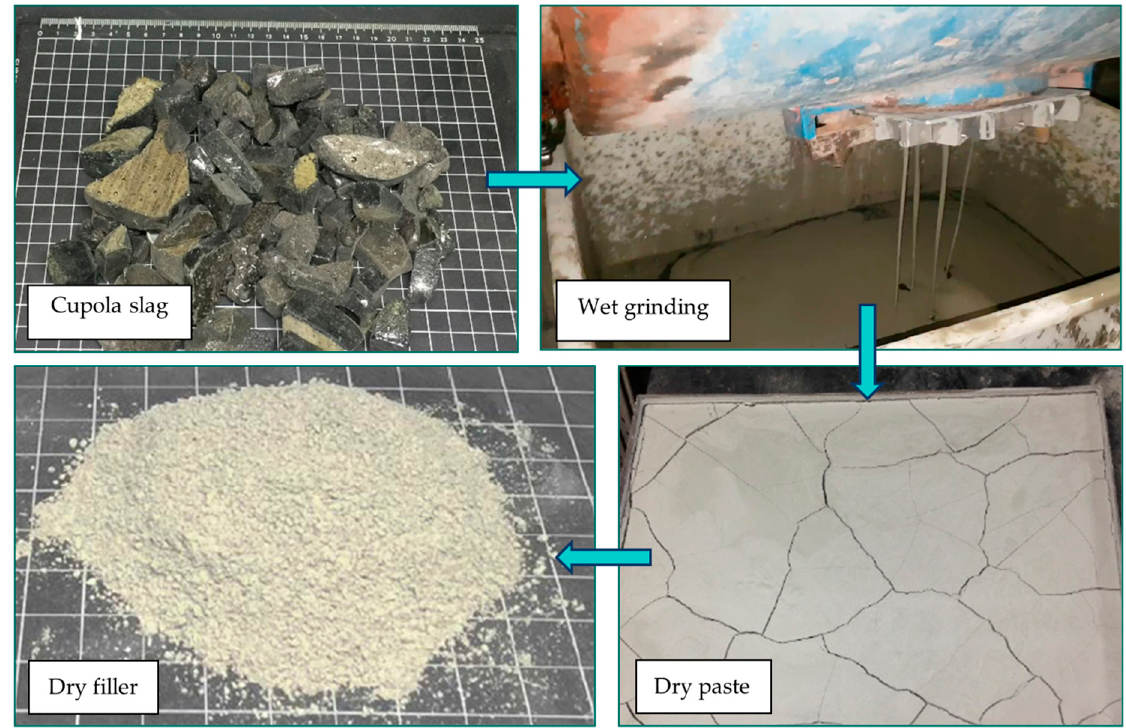
Figure 2. Scheme of the recovery process of cupola slag.